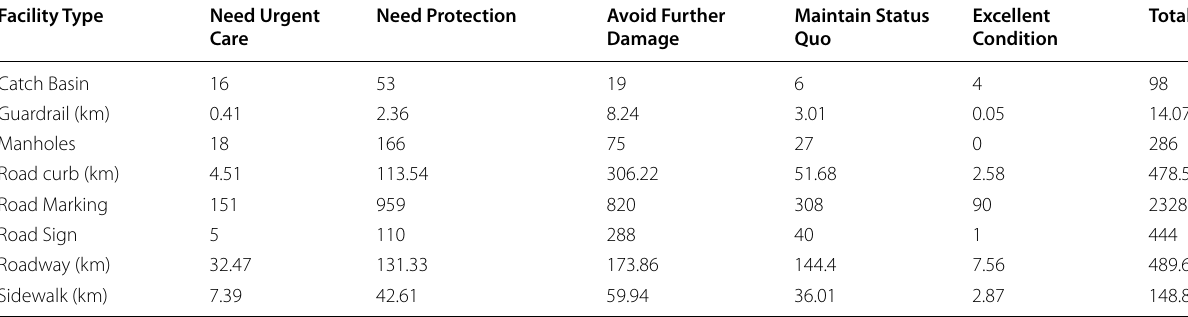
Table 6 The evaluation results of different facilities and their quantity in 5 maintenance levels Facility Type Need Urgent Need Protection Avoid Further Care